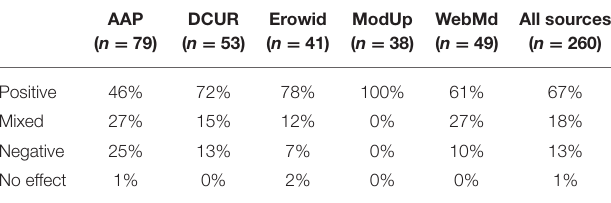
TABLE 3 | Manual assessment of perceived effectiveness across data sources (%